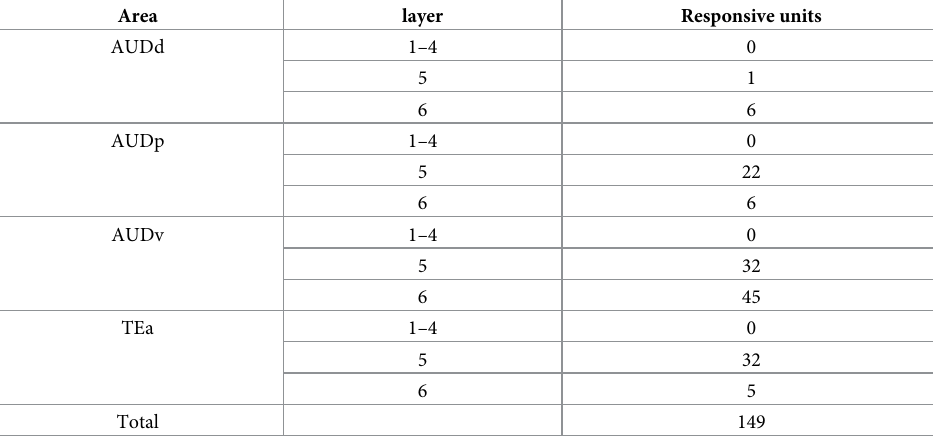
Table 1. Breakdown of cortical areas and layer distribution of the responsive